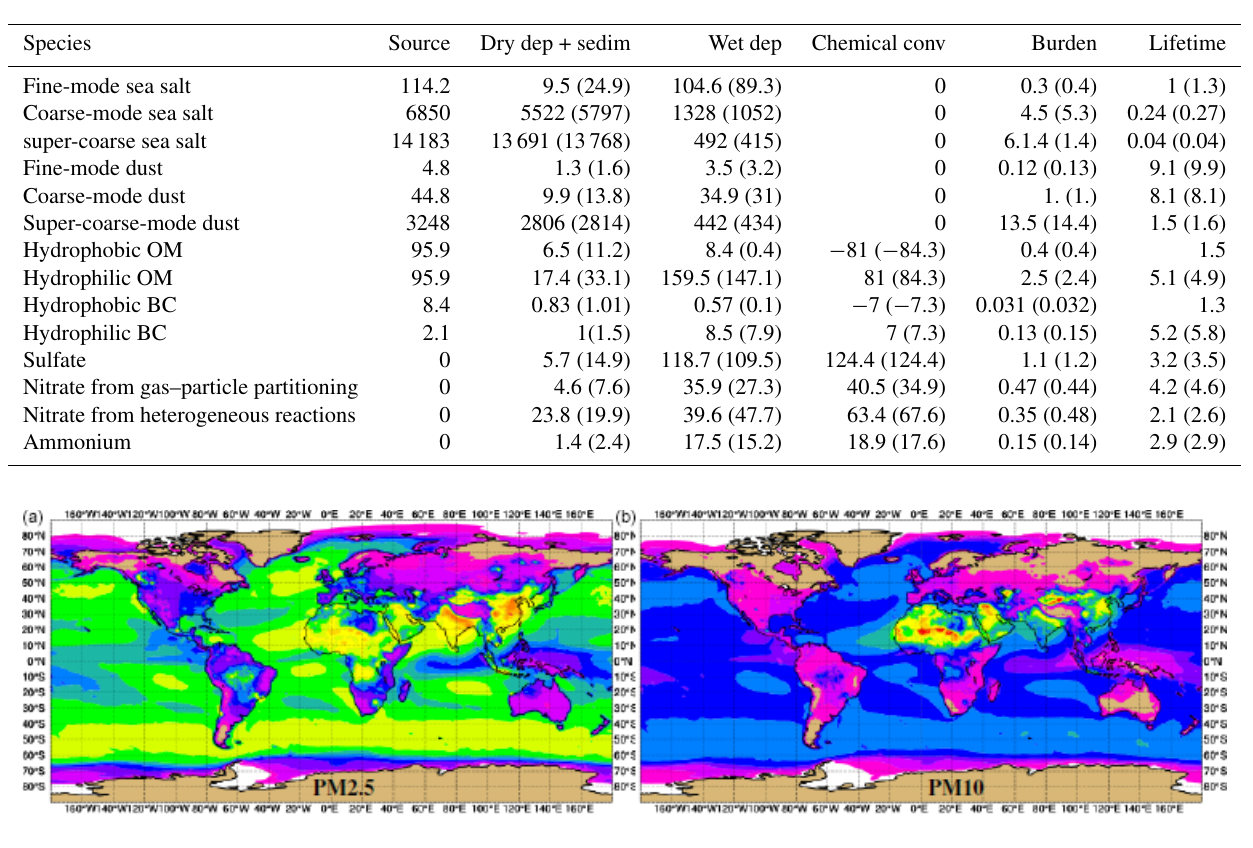
Table 9. CY47R1 IFS-AER mean budgets of dry aerosols for 2017 (fluxes are expressed in Tgyr − 1 , burdens in Tg and lifetimes in d). Values from the CY47R1_NEWDEP experiments are shown in parentheses.